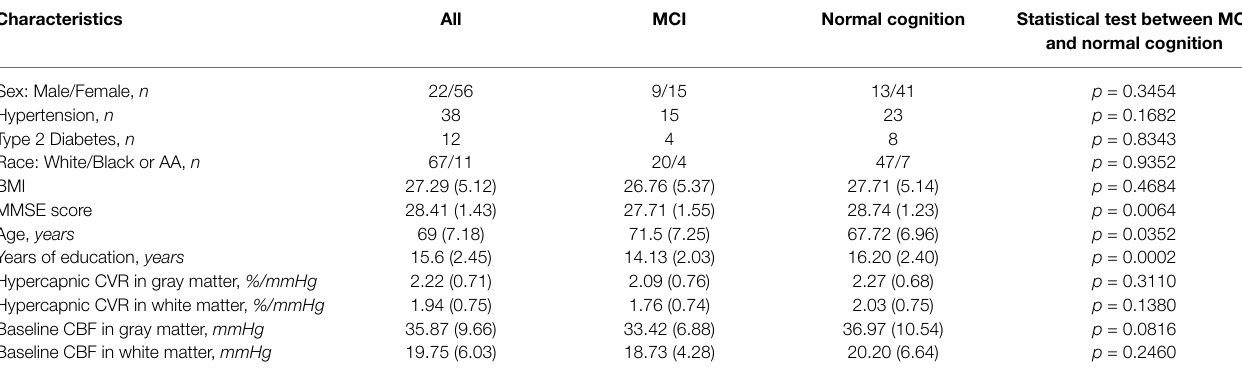
TABLE 1 | Characteristics of the study